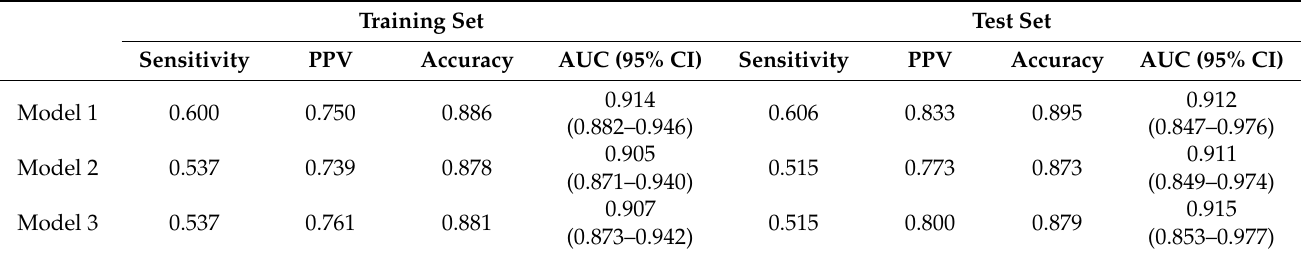
Table 2. Comparison of the prediction models for the requirement of mechanical ventilation. Training Set